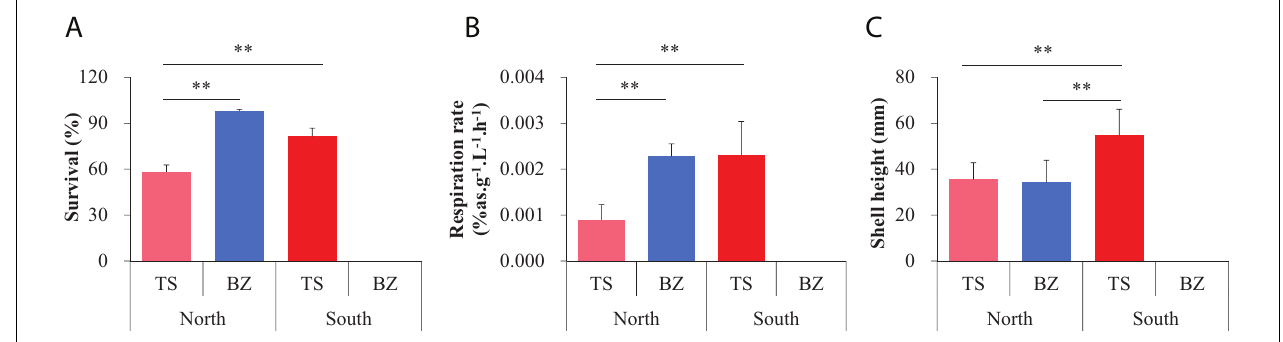
FIGURE 3 | Measurements for fitness-related traits, including (A) survival, (B) respiration rate, and (C) shell height, of the northern and southern estuarine oyster populations in the northern and southern habitats using reciprocal transplant experiments for three months post attachment. Asterisks indicate significant differences (** p < 0.01), and error bars represent sd